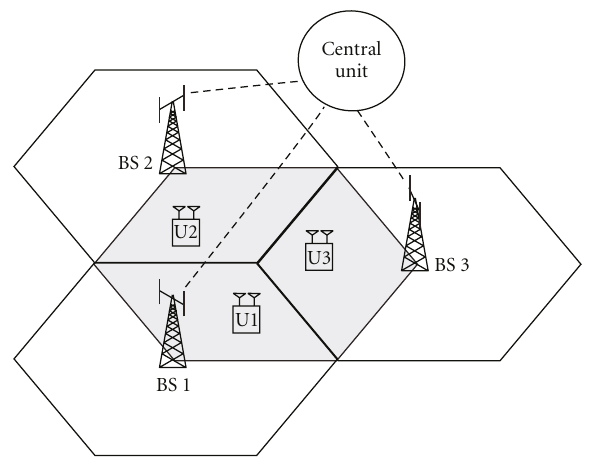
Figure 1: A network MIMO system with 3 BSs, connected to a central unit via backhaul links.